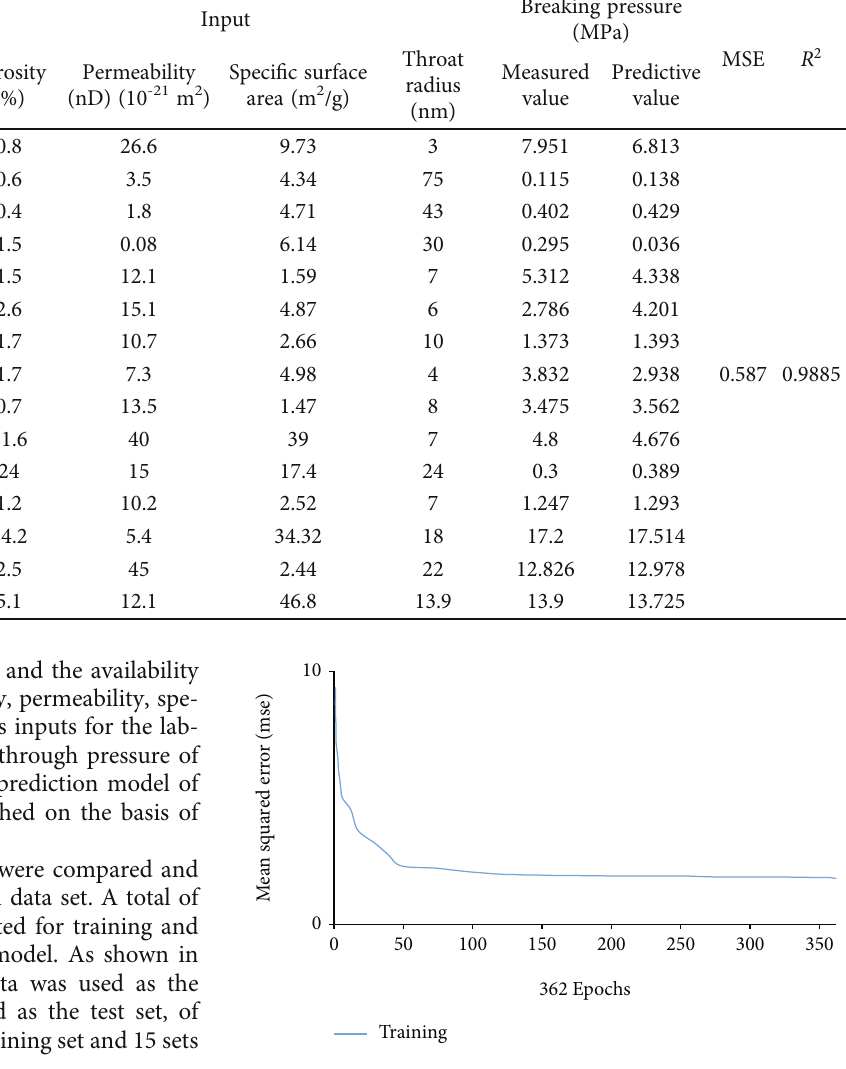
Figure 12: Convergence process of BP neural network